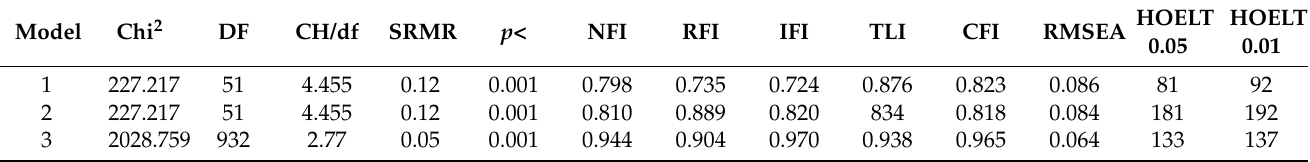
Table 7. Models of structural linear results of the